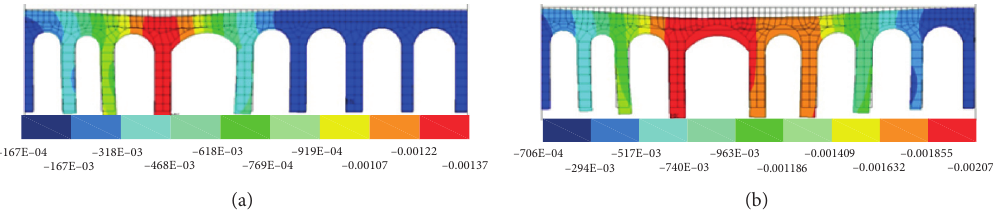
Figure 8: Structural deformation of aqueduct. (a) After the excavation of the left tunnel. (b) After the excavation of the right tunnel.